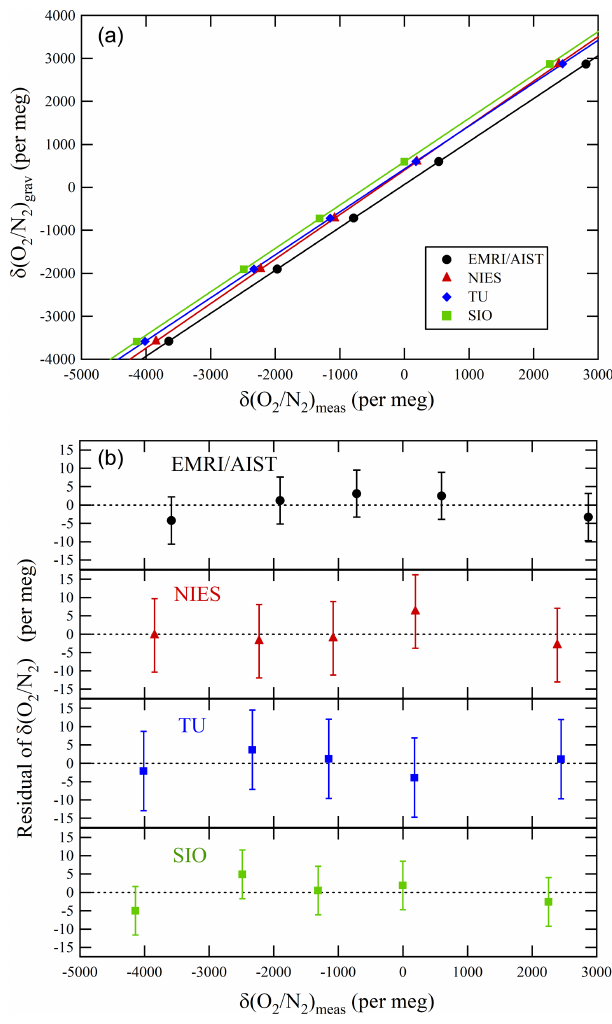
Figure 3. (a) Relationships between the gravimetric δ (O 2 / N 2 ) values by NMIJ/AIST and the δ (O 2 / N 2 ) values measured by EMRI/AIST, NIES, TU, and SIO as well as lines obtained from the Deming least-square fit to the plotted data. (b) Residuals of the measured δ (O 2 / N 2 ) values from the lines. The error bar represents expanded uncertainty, which was calculated based on the measure- ment uncertainty for individual